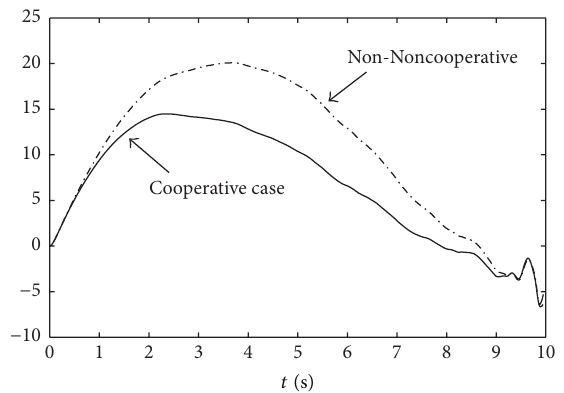
Figure 9: The Defender acceleration.